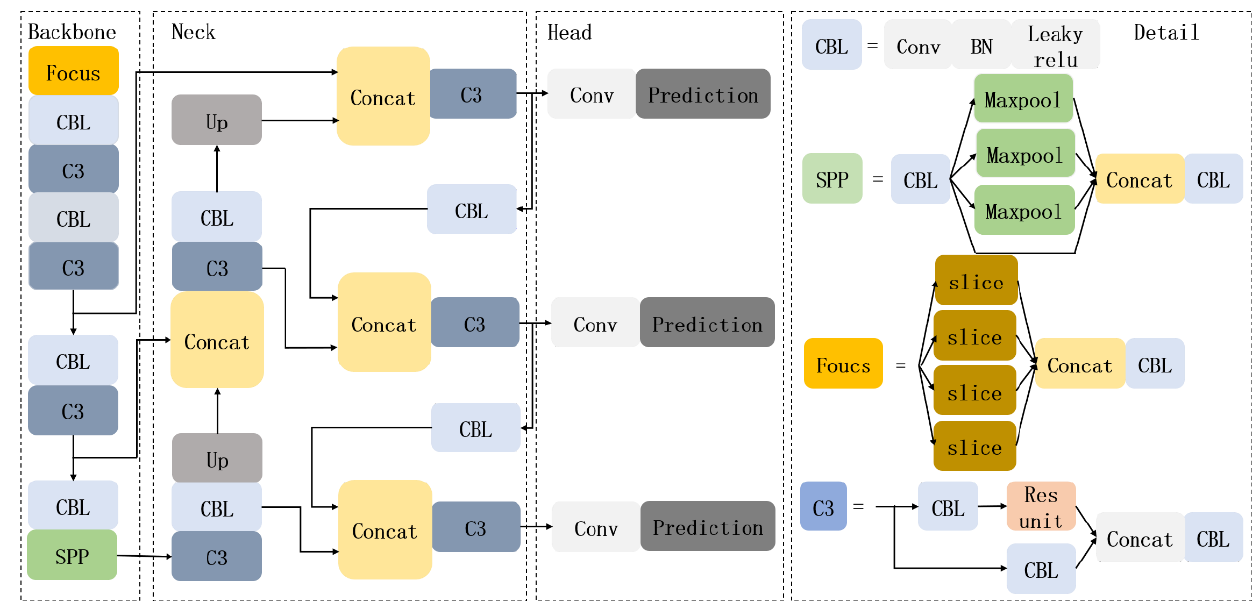
Figure 9. Architecture of the original YOLOv5 network.